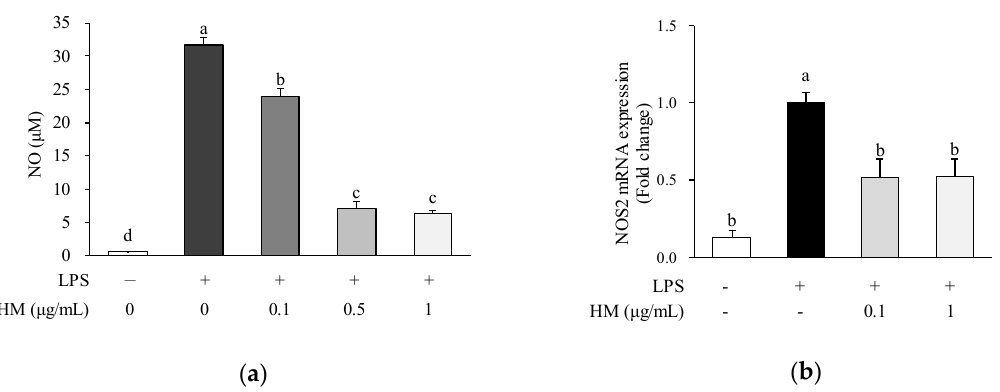
Figure 3. Effects of HM on NO production and NOS2 mRNA expression in RAW264.7 cells. Cells were pre-incubated with indicated concentrations of HM for 1 h and then co-incubated with LPS (1 µ g/mL) for 24 h. ( a ) The amount of NO in culture medium was analyzed using a Griess Reagent kit. ( b ) NOS2 mRNA level was determined by qRT-PCR. Values are expressed as mean ± SEM ( n = 4). Different superscript letters indicate statistical significance ( p < 0.05). NO, nitric oxide; NOS2, nitric oxide synthase 2; LPS, lipopolysaccharide; HM, high hydrostatic pressure extract of mulberry fruit.